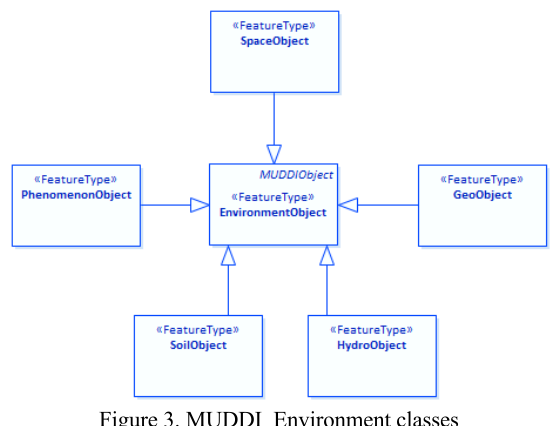
Figure 3. MUDDI_Environment